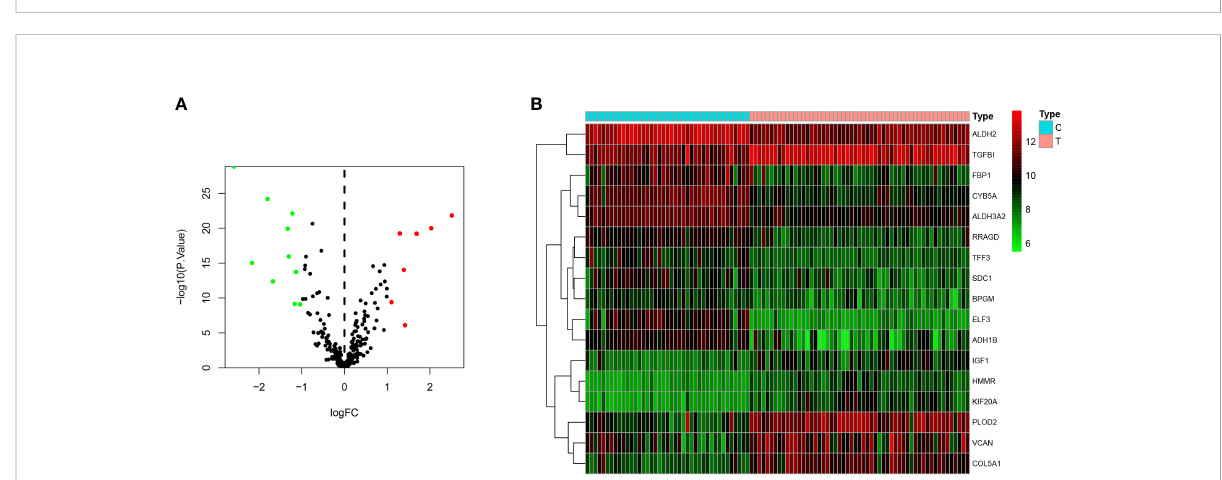
FIGURE 3 Differentially expressed genes between MPM and normal tissues. (A) The volcano plot of 17 differentially expressed genes (The red dots represent the level of high expression and the green dots represent the level of low expression). (B) Heatmap of 17 differently expressed genes (The depth of red represents the level of high expression, and the depth of green represents the level of low